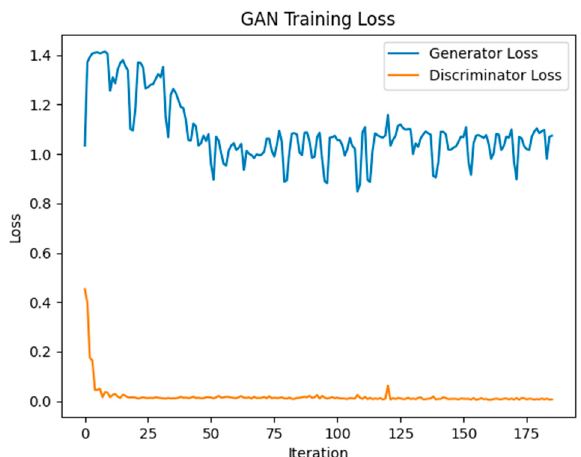
Figure 7. The Loss Trend of improved Discriminator Networks and Generator.